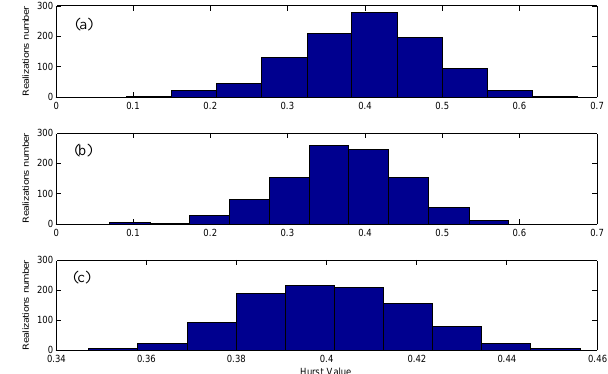
Fig. 1. Histograms of the Hurst values obtained by the three meth- Figure 1. Histograms of the Hurst values obtained by the three methods: (a) LWA (b) ALWA2 ods: (a) LWA, (b) ALWA, (c) PA, from 1000realizations of a syn- (c) PA, from 1000 realizations of a synthetic nhBm s(z) corresponding to a four-layer3 thetic nhBm s(z) corresponding to a four-layer geological model at geological model at the position (z=121.77m), located in the second layer (theoretical H-value4 the position ( z =121.77m), located in the second layer (theoretical =0.4).5